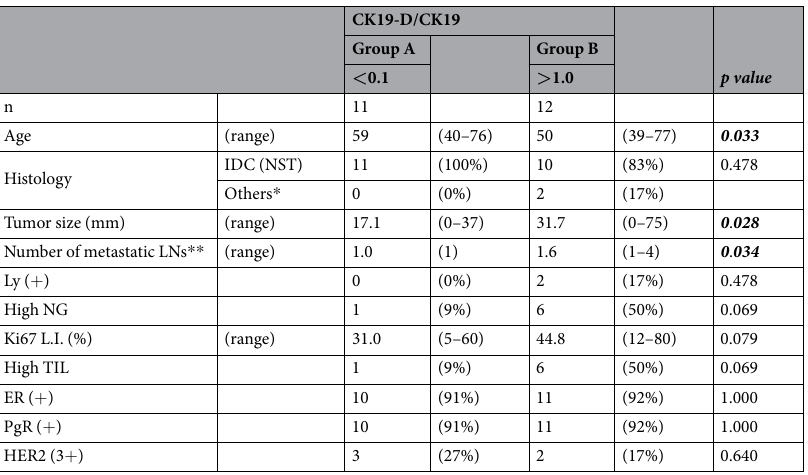
Table 2. Comparison of clinicopathological features between Groups A and B. * Other than NST. ** Mean number of total metastatic